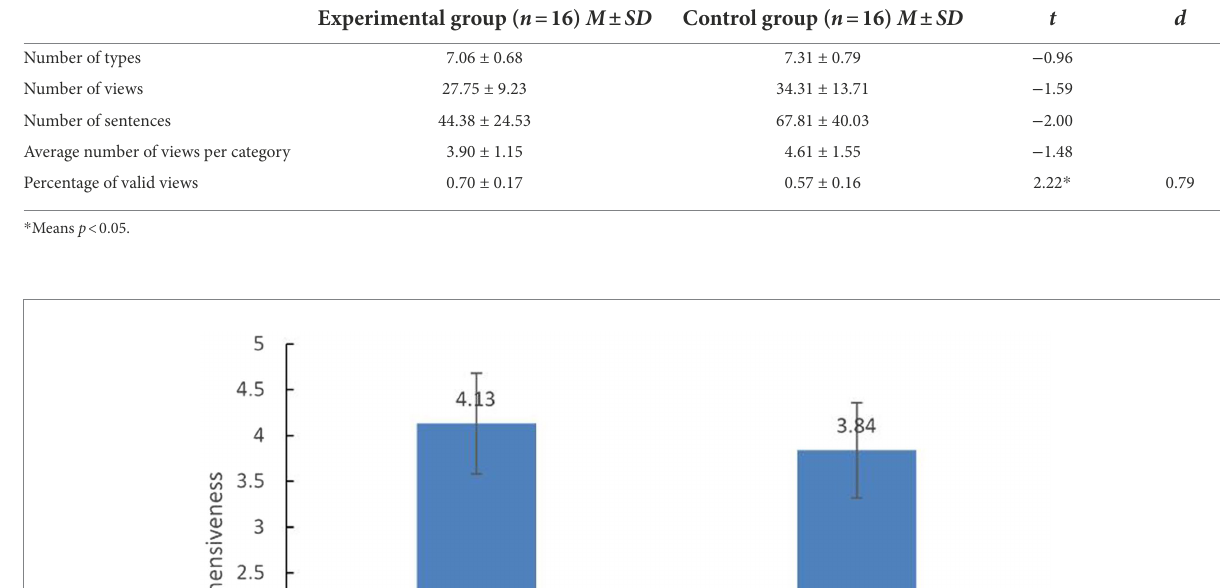
TABLE 3 Comparison of the breadth and depth of discussion between the two conditions.